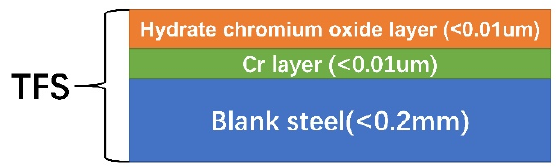
Figure 3. Schematic diagram of the tin free steel (TFS) surface coating structure.